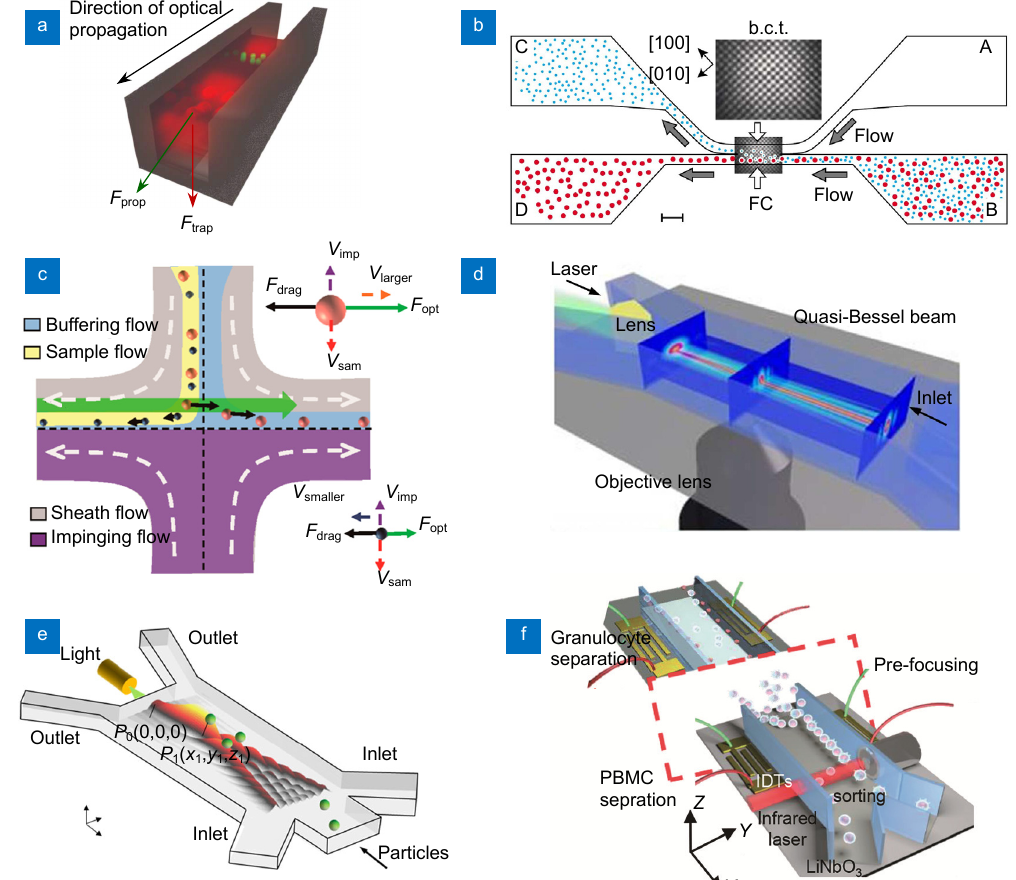
Fig. 6 | ( a ) Biomolecules detection based on optical force in sub-wavelength slot waveguides. ( b ) Cells sorting in an optical lattice. ( c ) Gold na- noparticles sorting in flowing system. ( d ) Multi-range particles sorting by quasi-Bessel beam. ( e ) Microparticles sorting based on optical lattice and chromatography. ( f ) Cell sorting by a new method combing acoustic force and optical force. Figure reproduced from: ( a ) ref. 60 , Macmillan Publishers Limited; ( b ) ref. 58 , Nature Publishing Group; ( c ) ref. 61 , American Chemical Society; ( d ) ref. 62 , The Royal Society of Chemistry; ( e ) ref. 63 ; ( f ) ref. 70 , The Royal Society of